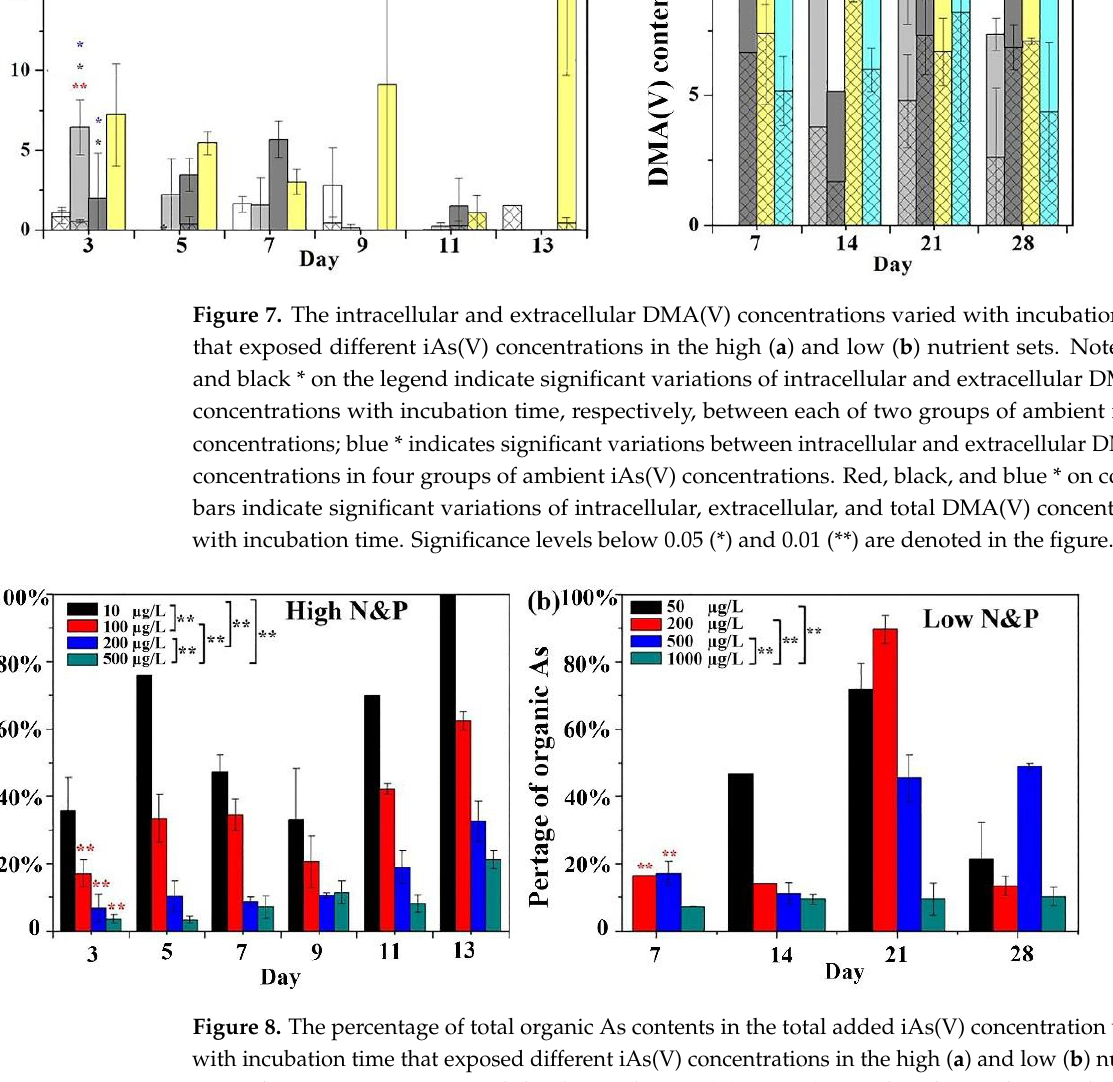
Figure 8. The percentage of total organic As contents in the total added iAs(V) concentration varied with incubation time that exposed different iAs(V) concentrations in the high ( a ) and low ( b ) nutrient sets. The organic As contained the detected MMA(V), DMA(V), and undetected As in the study. Note: Black * on the legend indicates significant variations of percentage of organic As concentration with incubation time between each of two groups of ambient iAs(V) concentrations. Red * on column bars indicates significant variations of percentage of organic As concentration with incubation time for each group of ambient iAs(V) concentration. Significance levels below 0.01 (**) are denoted in the